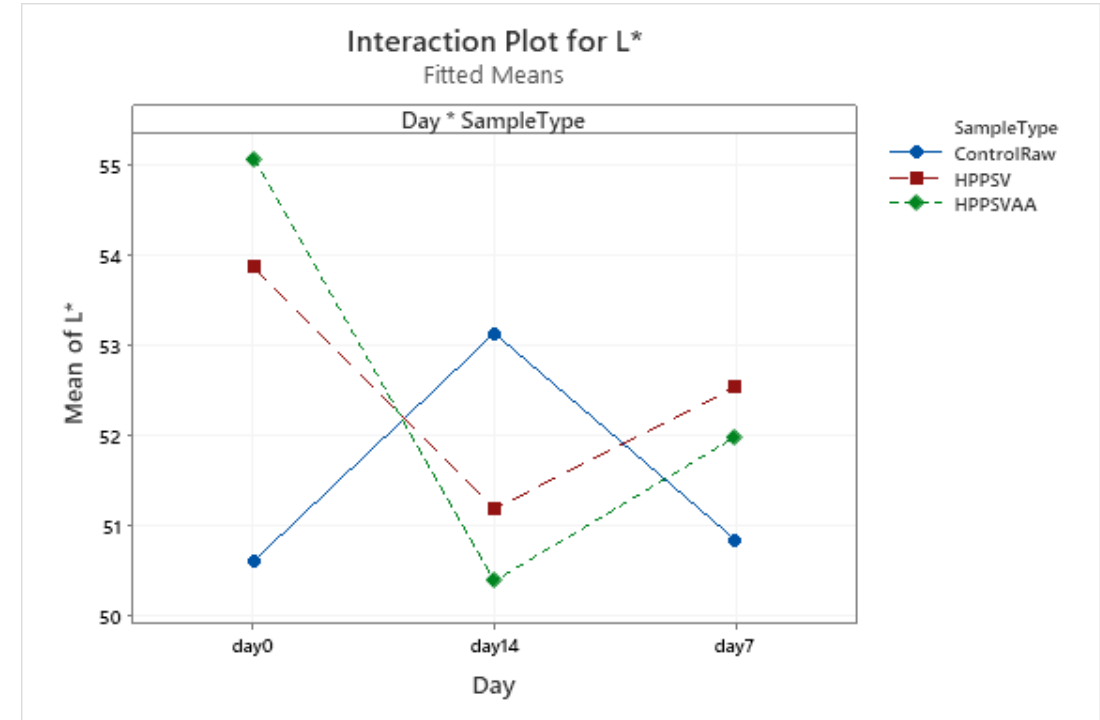
Figure A18. Effect of treatments and storage time on the b * coordinate of plant-based patty (HPPSV: HPP-SVCOOK).